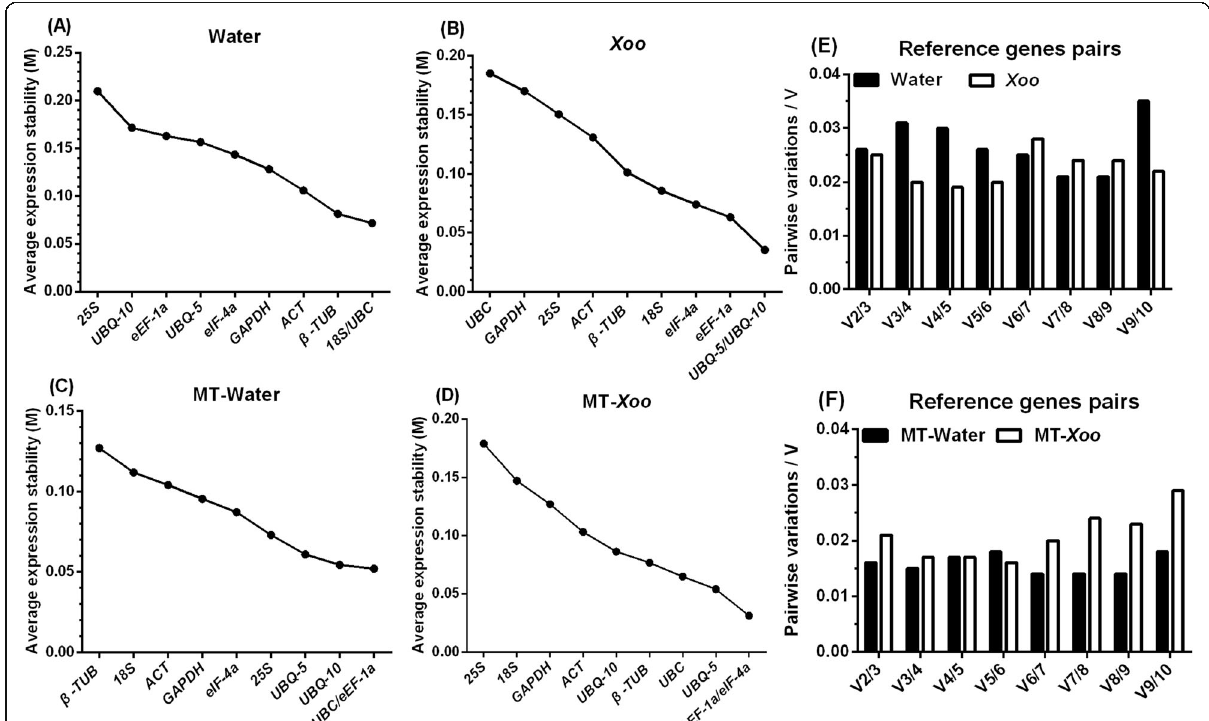
Fig. 3 Expression stability of the candidate reference genes assessed by geNorm analysis. a - d Expression stability of candidate reference genes in water-inoculated rice plants, in Xoo -infected rice plants, in MT-water infected rice plants and in MT- Xoo infected rice plants; e - f The pairwise variation value of reference genes in water and Xoo rice plants, in MT-water and MT- Xoo rice